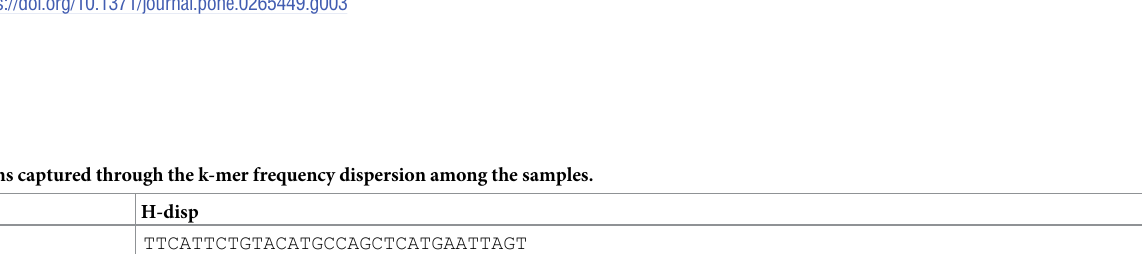
Fig 3. Comparison of the four junctions of the chloroplast quadripartite structure, grouping species with similar junctions, based on [21]. � ndhA with one exon; �� ndhA with two exons.